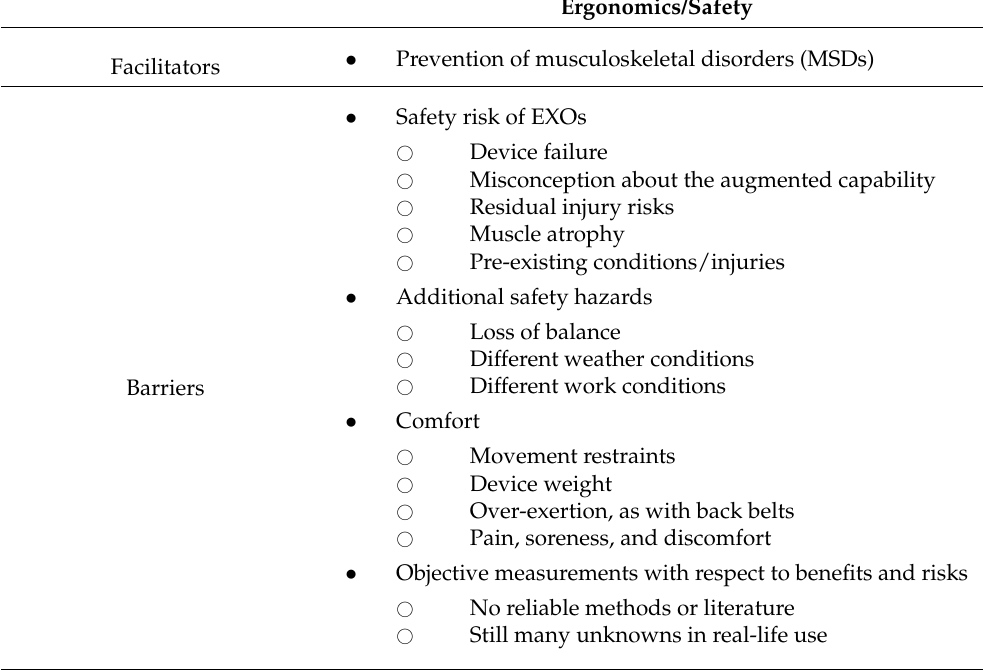
Table 7. Summary of ergonomics/safety category